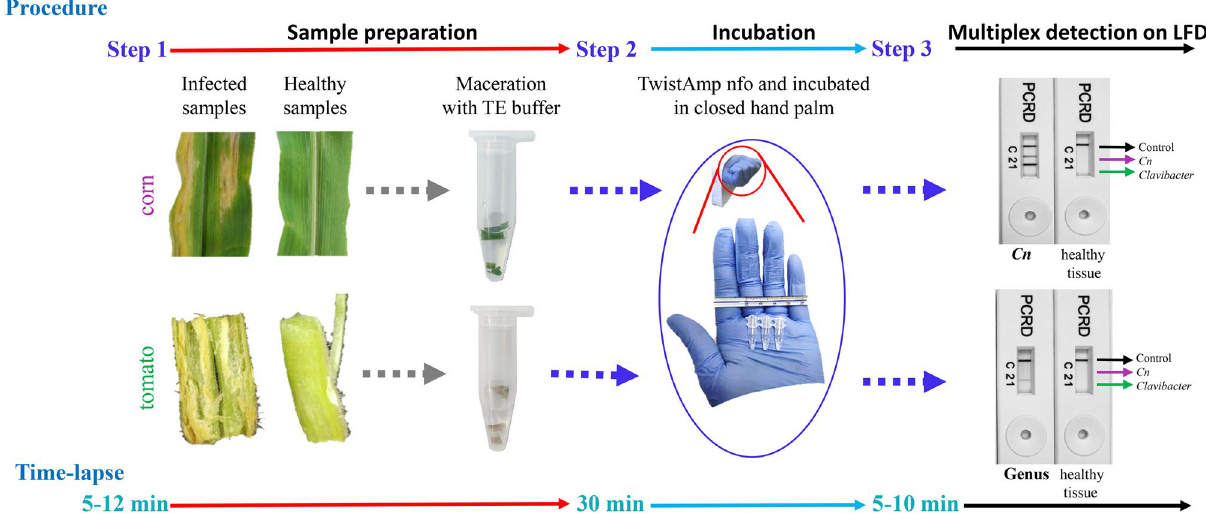
Figure 5. Schematic steps involve performing multiplex RPA intend for on-filed detection of genus Clavibacter in general and C. nebraskensis . Line 1: detects Clavibacter species/subspecies strains; line 2 detects C. nebraskensis strains, and; line C is a control line. The primer/probe sets for genus Clavibacter and C. nebraskensis are labeled with Biotin/DIG and Biotin/FAM, respectively. Step 1, both infected and healthy plant tissues were processed using TE buffer and a pestle; Step 2, the crude extract was directly used in RPA reactions as a template and incubated using closed hand palm for 30 min; Step 3, visual detection of multiplex RPA results on RPA- PCRD test strips displaying a specific detection of Clavibacter and C. nebraskensis from corn leaves in the upper PCRD, while Clavibacter detection from tomato stem in the lower PCRD. All the reactions were carried out using multiplex assays with TwistAmp-nfo kit. No cross-reactivity or negative results were observed despite using plant extract that contains plant